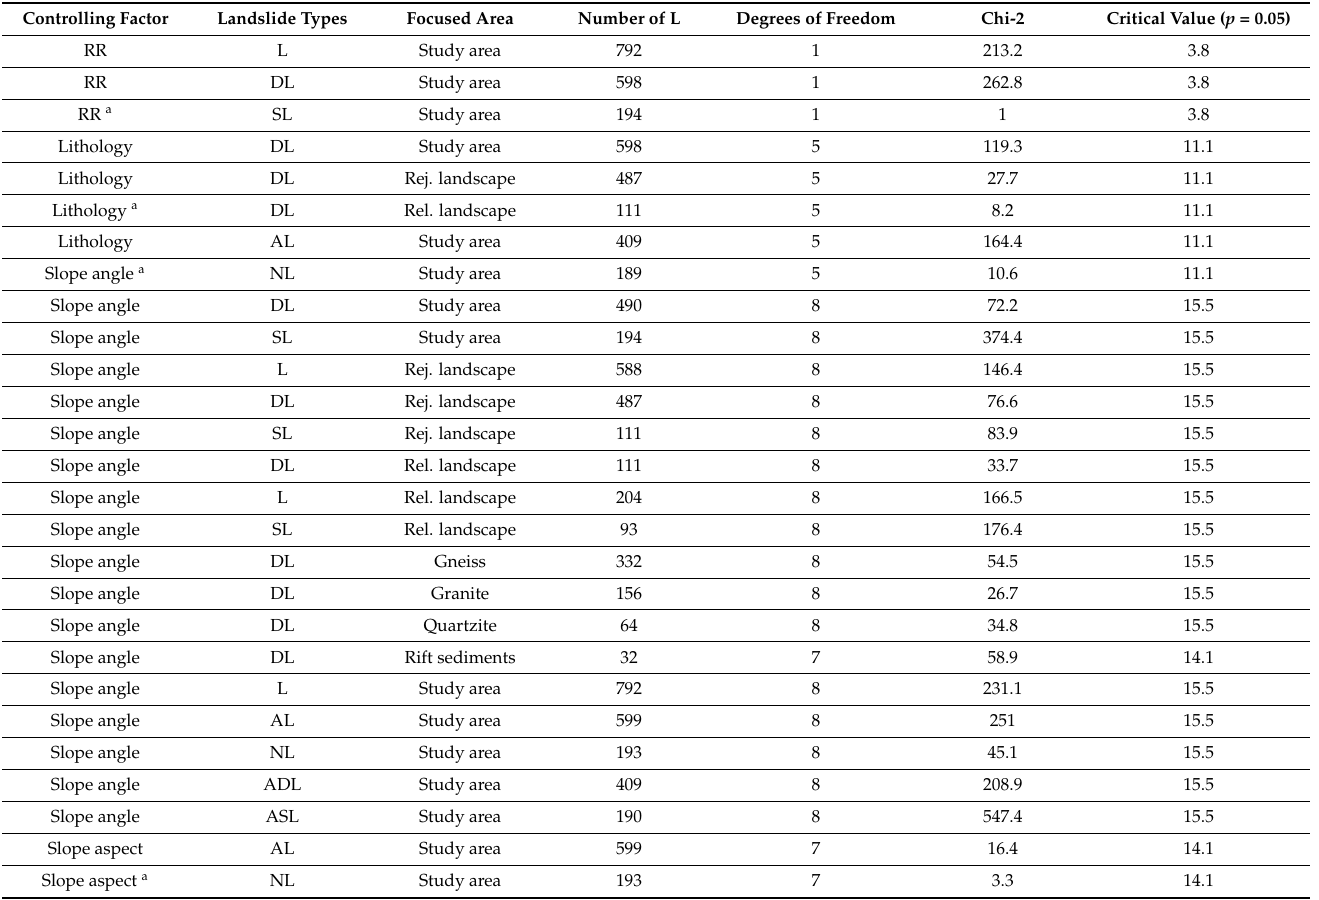
Table 4. Association between the occurrence of landslides (L) and the controlling factors. DL: deep-seated landslide; SL: shallow landslide; AL: active landslide; NL: non-active landslide; ADL: active deep-seated landslide; ASL: active shallow landslide; RR: relief differentiation into the rejuvenated (Rej) and relict (Rel)